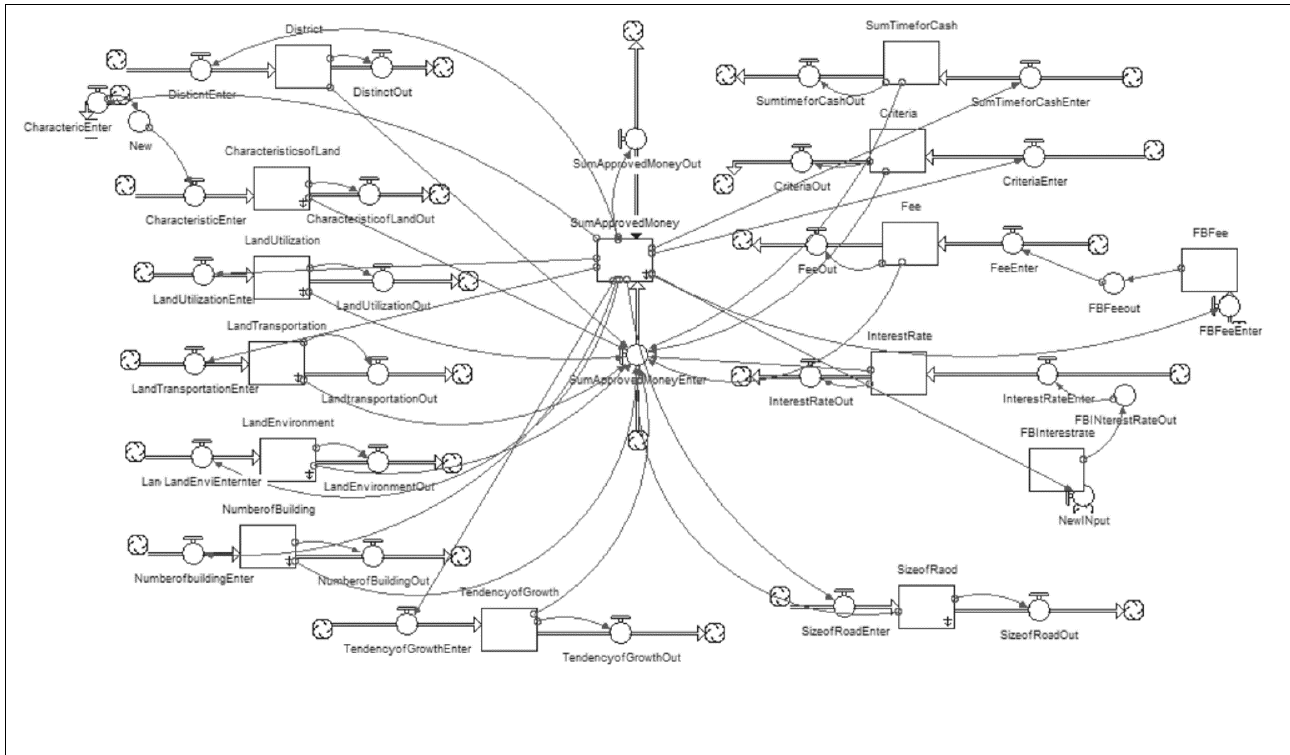
Figure 7. Appraisal model by system dynamics.